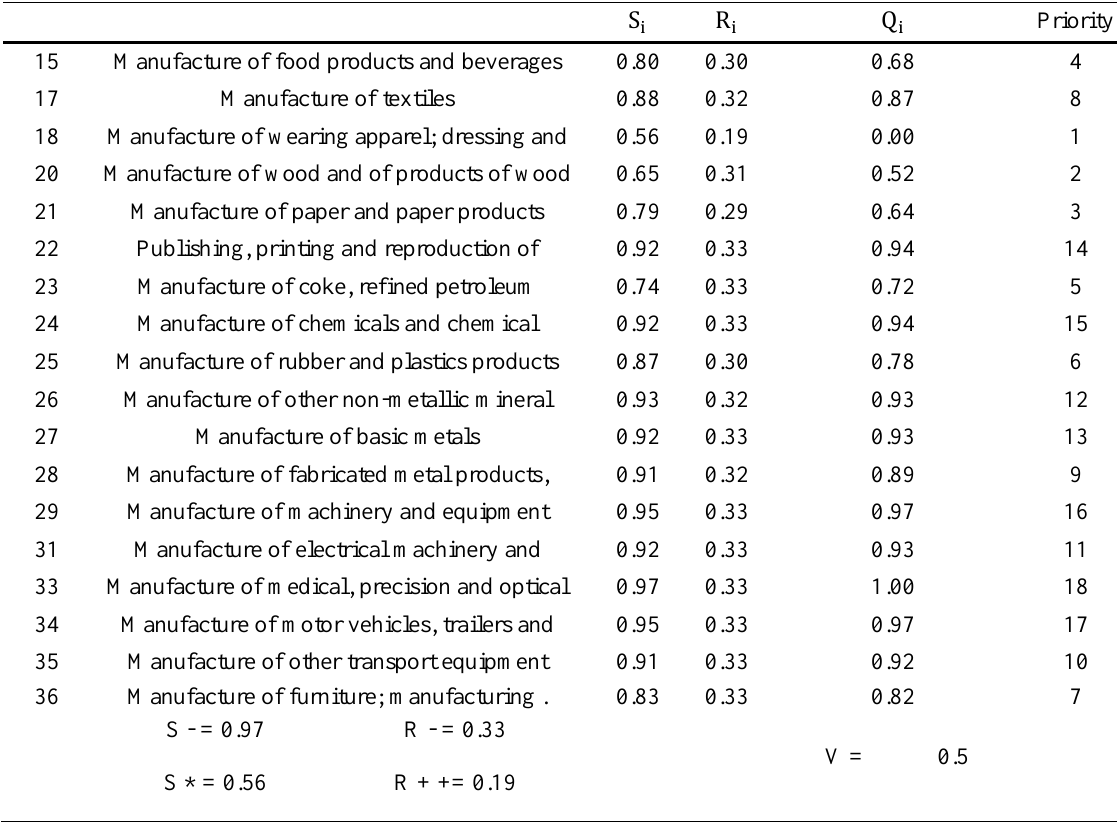
Table 5. Ranking the alternatives according to Qi, Si, and R i